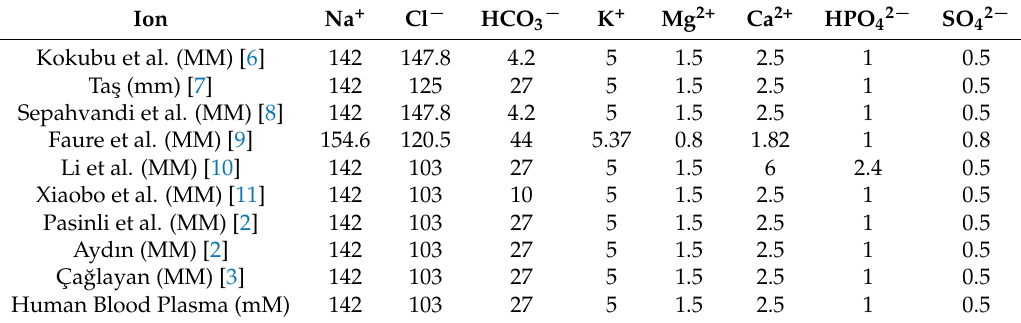
Table 1. Human blood plasma and ion concentration of simulated body fluid (SBF) [2,3,5].